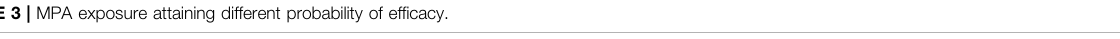
TABLE 3 | MPA exposure attaining different probability of ef fi cacy. Probability of ef fi